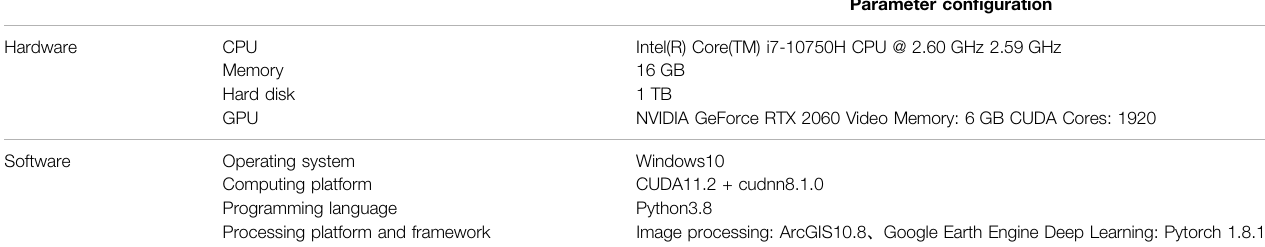
TABLE 2 | Hardware and software